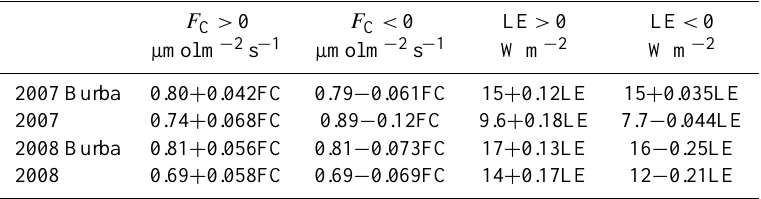
Table 1. Empirically determined linear relations used to estimate random errors ( σ ) in fluxes as a function of the flux magnitude for the Laguna Seca field site (see Richardson et al., 2006). Resulting standard deviations were used to add artificial noise following a Laplace distribution. Every R 2 was greater than 0.83. F C > 0 F C <